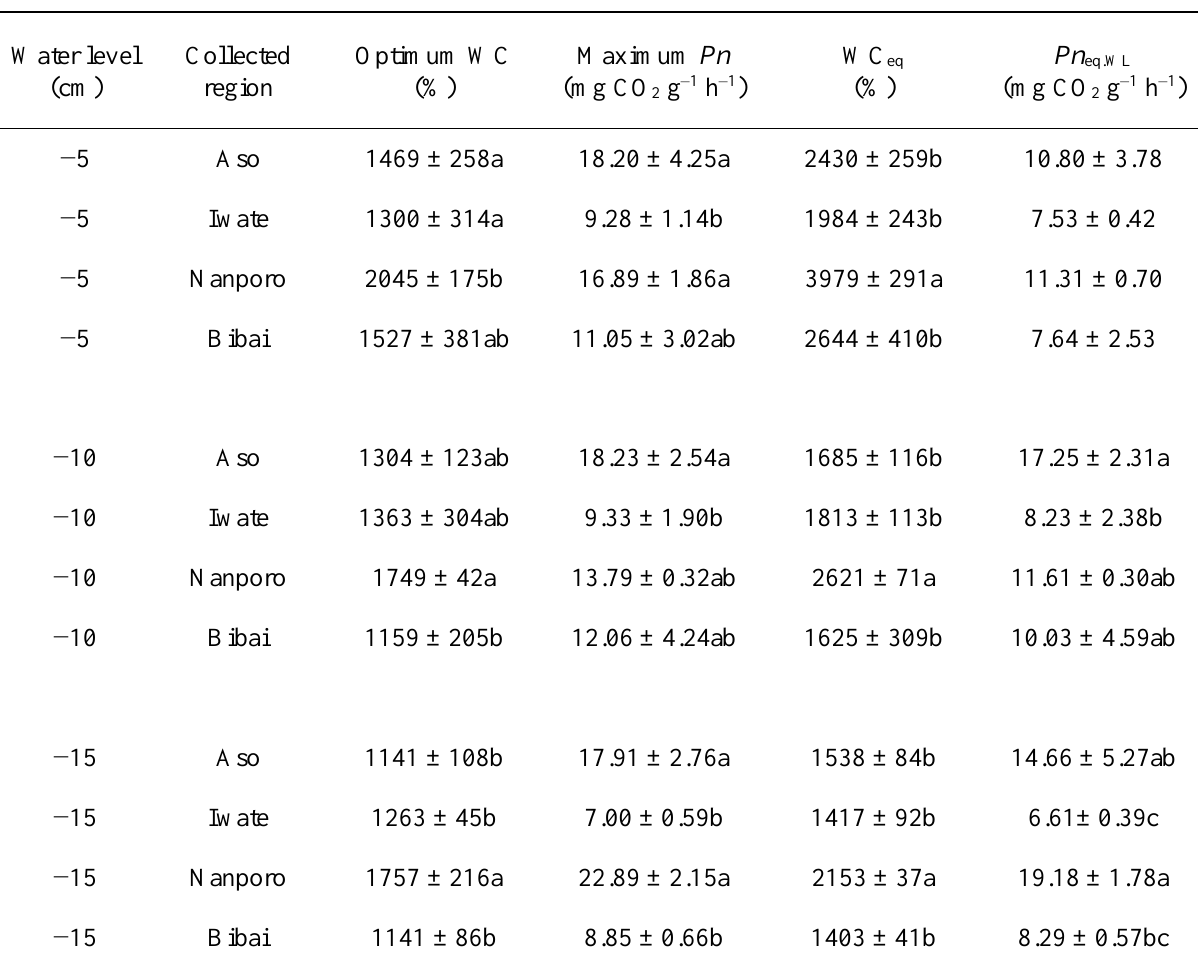
Table A1. Results of a Tukey-Kramer multiple comparison of optimum water content (optimum WC), maximum net photosynthetic rate (maximum Pn ), equilibrium water content specific to the water level (WC and net photosynthetic rate at WC ( Pn ) between samples of Sphagnum palustre originating from Aso, eq eq.WL Iwate, Nanporo and Bibai. The same suffixed letter indicates no significant difference ( p > 0.05) among collected